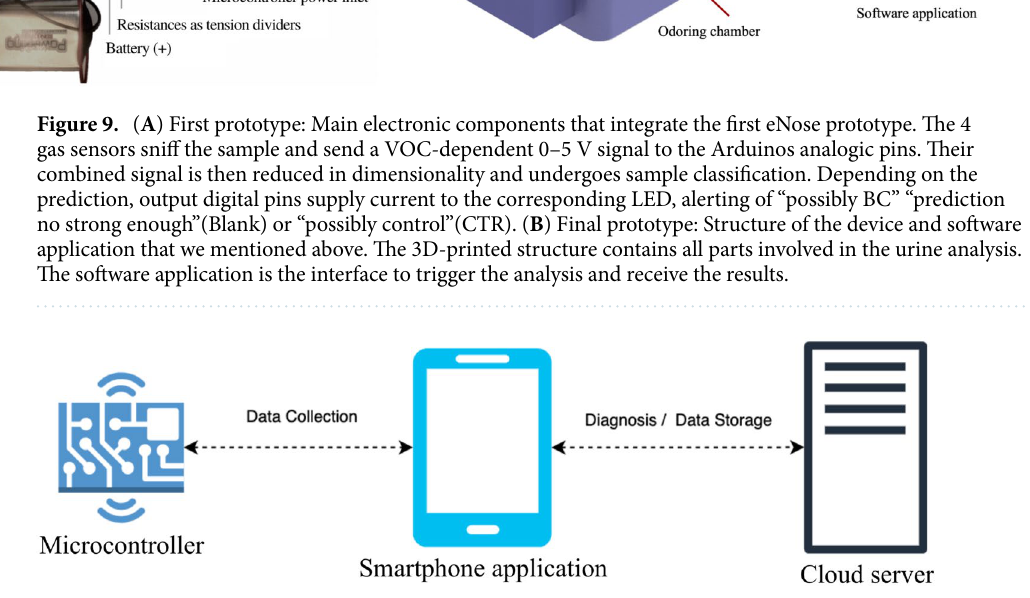
Figure 10. Connectivity workflow to gather data on edge and perform sample classification on the